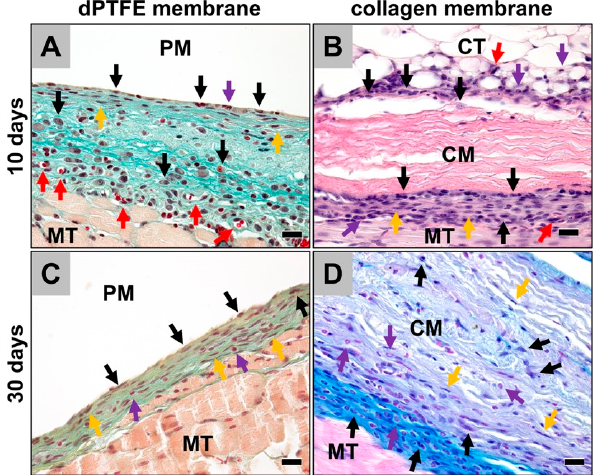
Figure 1. The histological images from the implantation beds of the analyzed membranes, i.e., the dPTFE membrane (PM) and the collagen membrane (CM) within the subcutaneous connective tissue (CT) (MT = muscle tissue). ( A ) At the surfaces of the dPTFE membrane, a thin layer of mononuclear cells that mainly belonged to the monocyte/macrophage line (black arrows) beside single granulocytes (purple arrow) were observable. Within the reactive peri-implant tissue, mainly macrophages (black arrows) and fibroblasts (yellow arrows) were found, besides small numbers of granulocytes and lymphocytes as well as some small vessels (red arrows) (Movat’s Pentachrome-staining, 400 × magnification, scale bar = 20 µ m). ( B ) Into the implant beds of the collagen membranes, a comparable tissue reaction, including mainly macrophages (black arrows) besides single eosinophils and fibroblasts (purple/yellow arrows) (haematoxylin and eosin (HE)-staining, 400 × magnification, scale bar = 20 µ m). At this time point only some single cells have migrated into the outer regions of the membrane body. ( C ) At day 30 after implantation, the wall of reactive tissue around the dPTFE membranes have visibly been decreased. Macrophages (black arrows) were still observed dominating the tissue reaction beside single eosinophils and fibroblasts (purple/yellow arrows) (Movat’s Pentachrome-staining, 400 × magnification, scale bar = 20 µ m). ( D ) Also, into the implant beds of the collagen membrane mainly macrophages (black arrows) have been detected at this time point, together with low numbers of eosinophils and fibroblasts (purple/yellow arrows). At day 30 after implantation, more cells have invaded the membranes body, while the material showed no signs of breakdown (Alcian blue-staining, 400 × magnification, scale bar = 20 µ m).